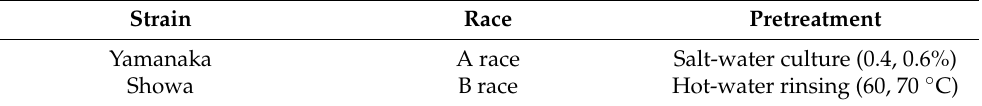
Table 1. Pretreatment methods for solvent extraction conducted on each strain of B. braunii . Strain Race Pretreatment Yamanaka A race Showa B race Hot-water rinsing (60, 70 ◦